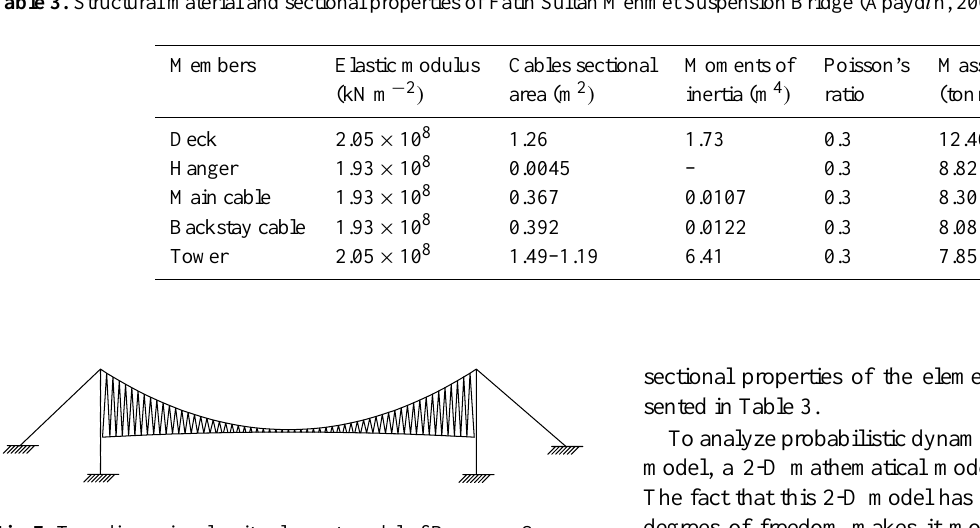
Fig.6. General Arrangement of Bosporus Suspension Bridge . Fig. 6. General Arrangement of Bosporus Suspension Bridge. Table 3. Structural material and sectional properties of Fatih Sultan Mehmet Suspension Bridge (Apayd ı n, 2002).